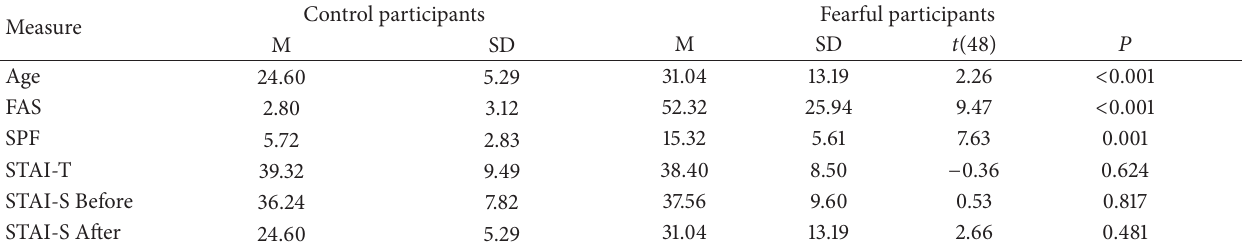
Table 1: Demographics and questionnaire means and standard deviations for both fearful and control participants.